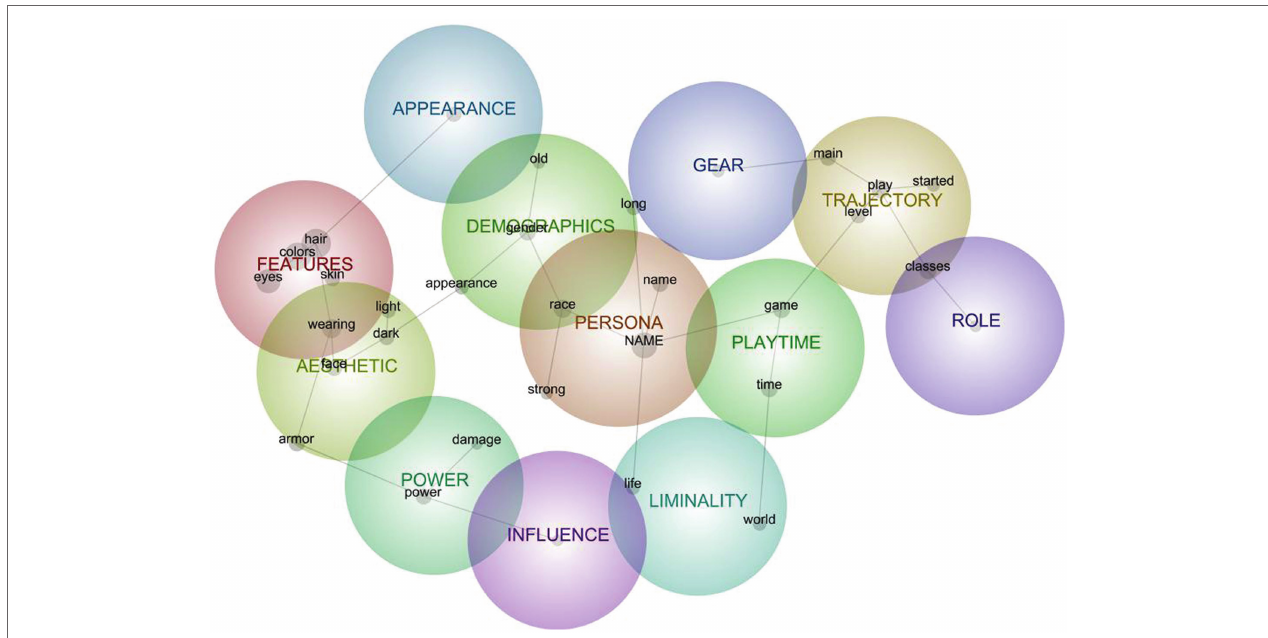
FIGURE 3 | Semantic network model for aggregated descriptions of avatars in Symbiote